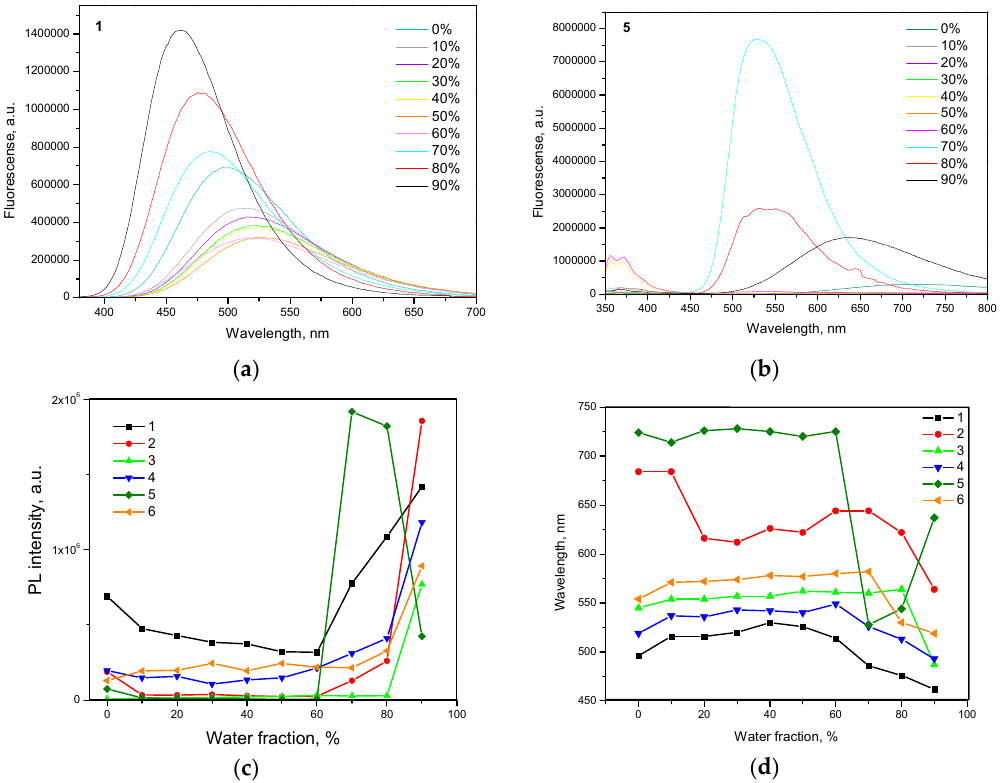
Figure 5. Emission spectra of compounds ( a ) 1 and ( b ) 5 in THF/water mixtures (0–90%). Plots of ( c ) maximum emission intensity and ( d ) wavelength versus water fraction for the dispersions of compounds 1–6 in the mixtures of THF and